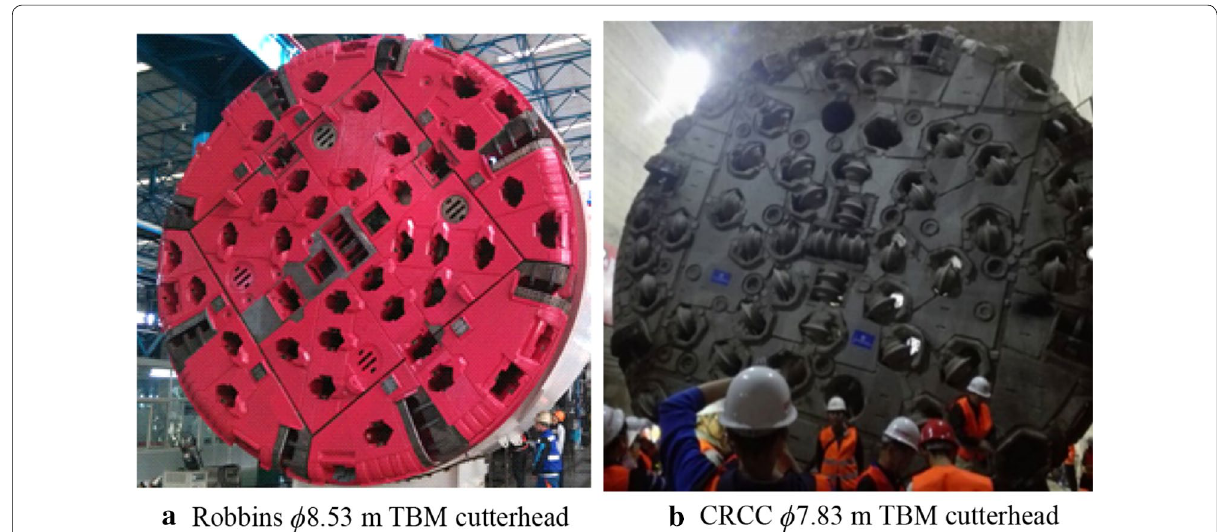
Figure 12 TBM cutterheads service in Liaoning northwest